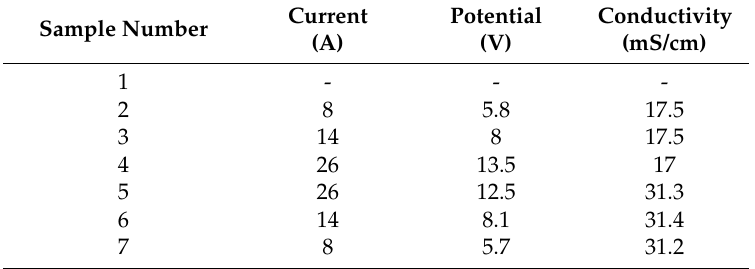
Table 2. Surface treatment parameters and physical properties of resultant fibres. Sample